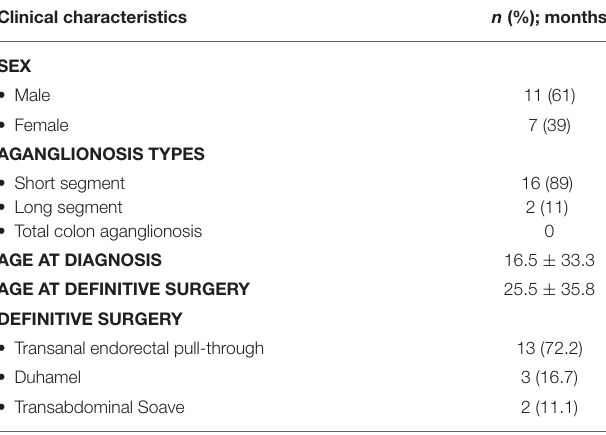
TABLE 2 | Clinical characteristics of the HSCR patients for SEMA3D expression study. Clinical